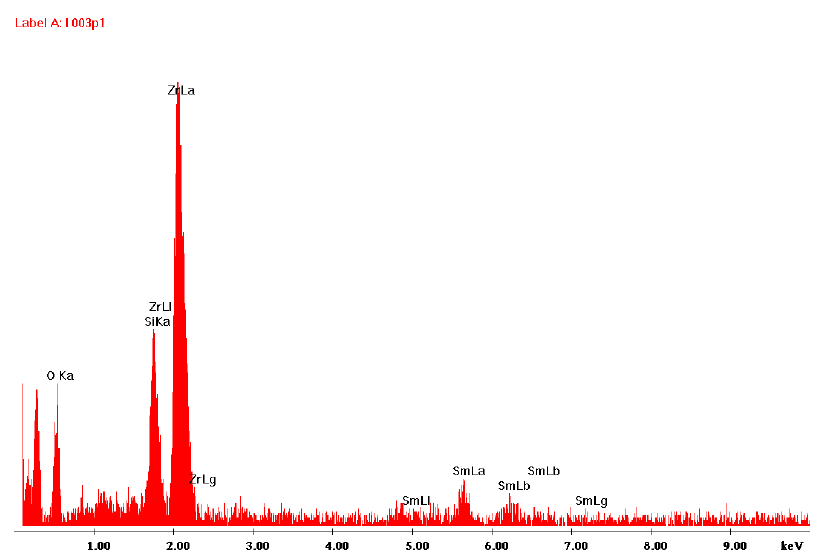
Figure 2. EDS spectrum obtained at point 1 of Figure 1.